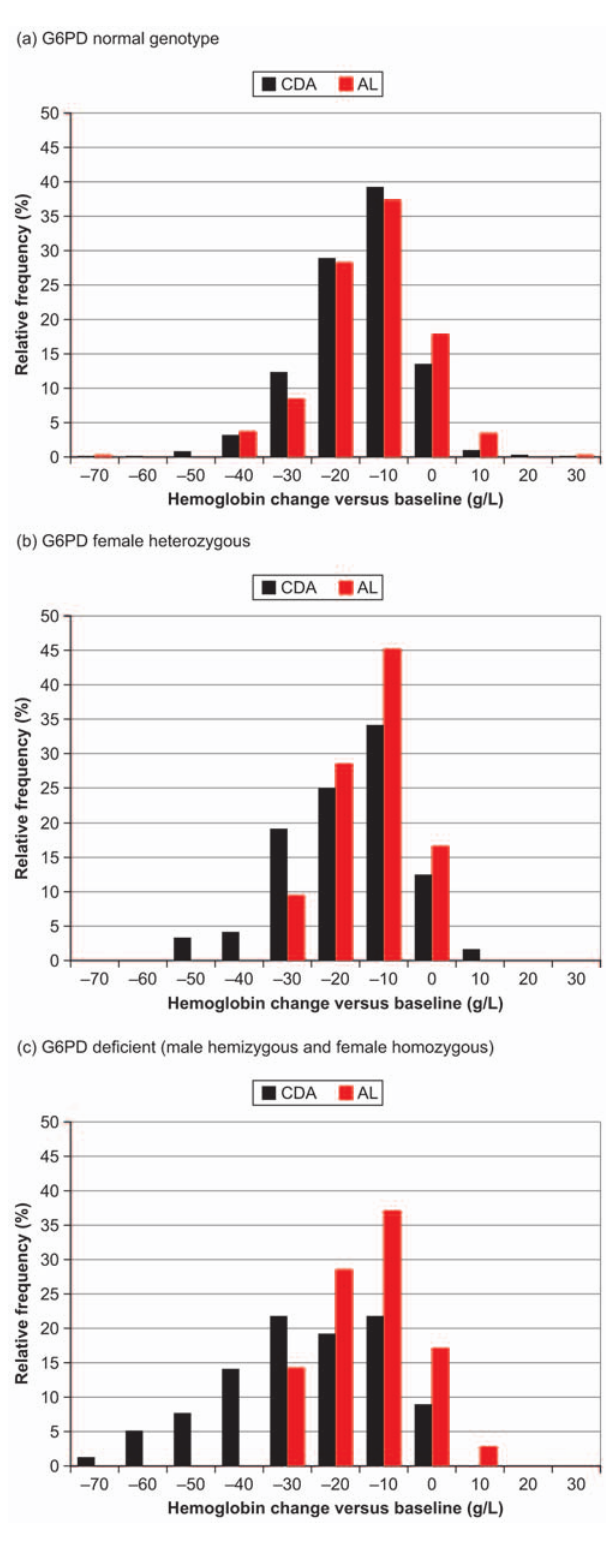
Figure 3. Relative frequency distribution for the maximum decrease in hemoglobin versus baseline at any time during the study, or minimum increase in hemoglobin versus baseline if hemoglobin values were greater than baseline throughout the study, by G6PD genotype: (a) normal; (b) female heterozygous; (c) deficient (male hemizygous and female homozygous).